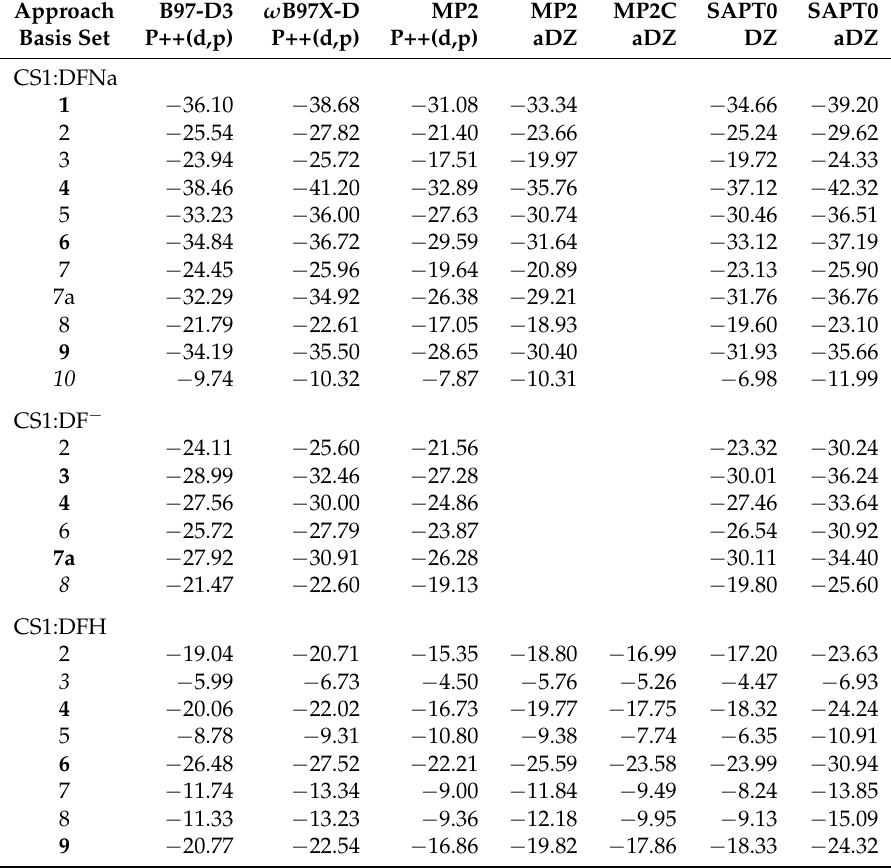
Table 1. B97-D3/6-311++G(d,p), ω B97X-D/6-311++G(d,p), MP2/6-311++G(d,p), MP2/aug-cc-pVDZ counterpoise corrected interaction energies [kcal/mol] and MP2C/aug-cc-pVDZ and SAPT0/cc-pVDZ and SAPT0/aug-cc-pVDZ total interaction energy single chitosan unit CS1 with DFNa, DF − and DFH (bold: most attractive B97-D3 interaction; italic: weakest B97-D3 interaction). P++(d,p) denotes Pople 6-311++G(d,p) basis set, DZ is Dunning cc-pVDZ basis set and aDZ is Dunning DZ augmented with a set of diffuse functions (aug-cc-pVDZ). For the system structures see Figures 1, 3 and 4 and Supplementary